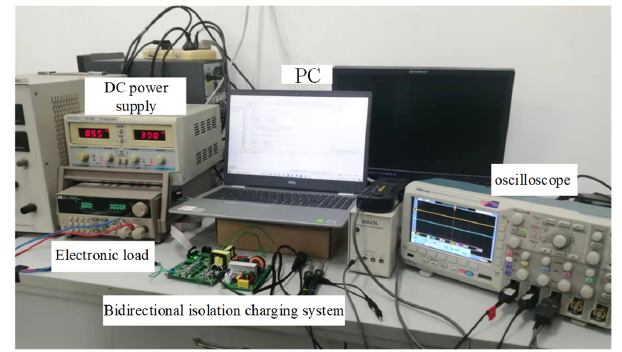
Figure 29. Experimental platform.